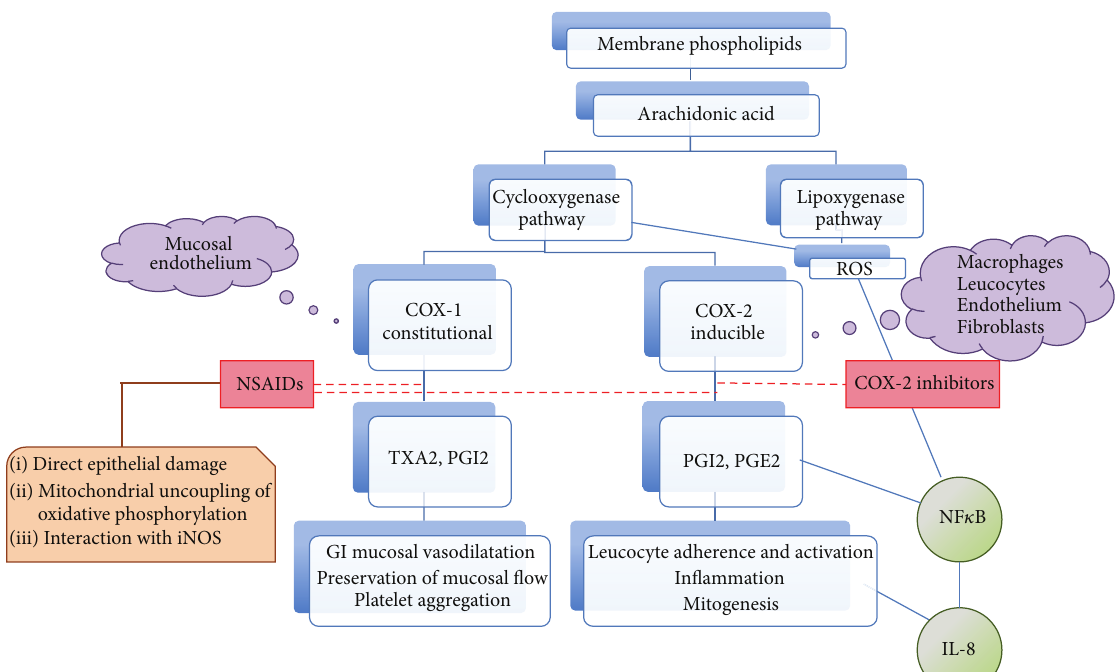
Figure 1: Effects of NSAIDs and selective COX-2 inhibitors. Phospholipase A2 acts on the membrane phospholipids to yield arachidonic acid (AA). AA is metabolized by either cyclooxygenase (COX) or lipoxygenase (LOX) pathway. Two unique COX isoenzymes convert AA into prostaglandin endoperoxides. COX-1 is expressed constitutively in most cells, including GI mucosal cells. In contrast, COX-2 is expressed by inflammatorycellsinresponsetoavarietyofstimuliincludingmicrobialproductsandcytokines.COX-1generatesprostanoidsresponsiblefor “housekeeping” function; they help with vasodilatation, preserving mucosal flow, and induction of platelet aggregation in response to vascular injury to prevent blood loss. COX-2 induction plays a part in leucocyte activation, adherence, and angiogenesis through effects on NF 𝜅 B and IL8. Reactive oxygen species generated due to enzymatic activities of COX and LOX also stimulate NF 𝜅 B and perpetuate the cycle. Inhibition of COX-2 prevents this inflammatory cascade and is responsible for clinical effects of NSAIDs and selective COX-2 inhibitors. NSAIDs, in addition, also block COX-1 pathway leading to mucosal injury, vasoconstriction, mucosal ischemia, and increased vascular permeability. NSAIDs may also lead to direct epithelial damage and mitochondrial uncoupling of oxidative phosphorylation. Dashed red line indicates enzymatic